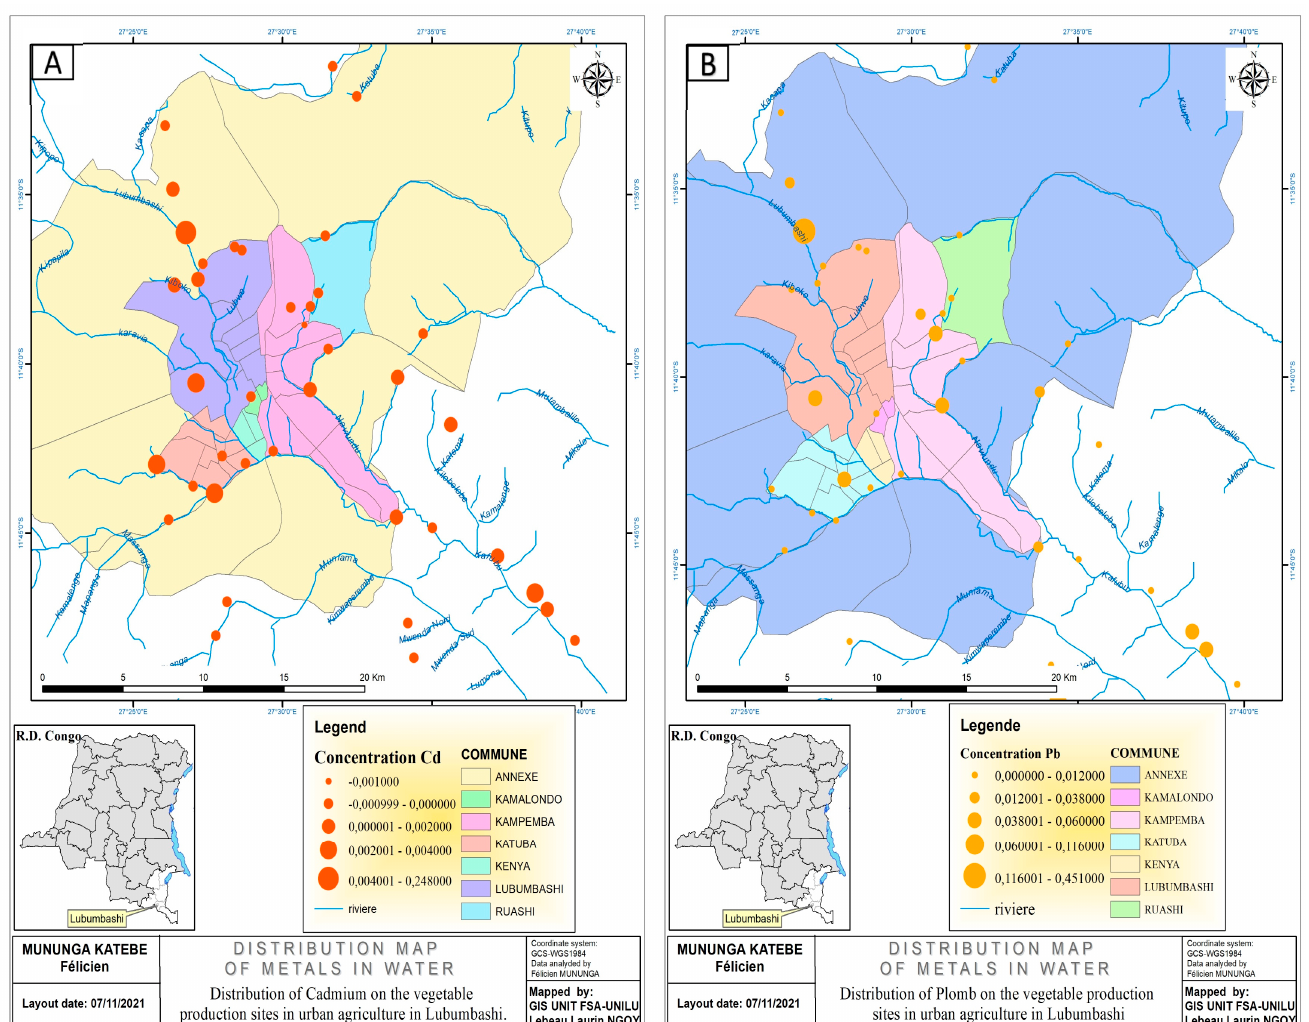
Figure 10. Spatial distribution of metals (Cd and Pb) in the waters of Lubumbashi market gardens.